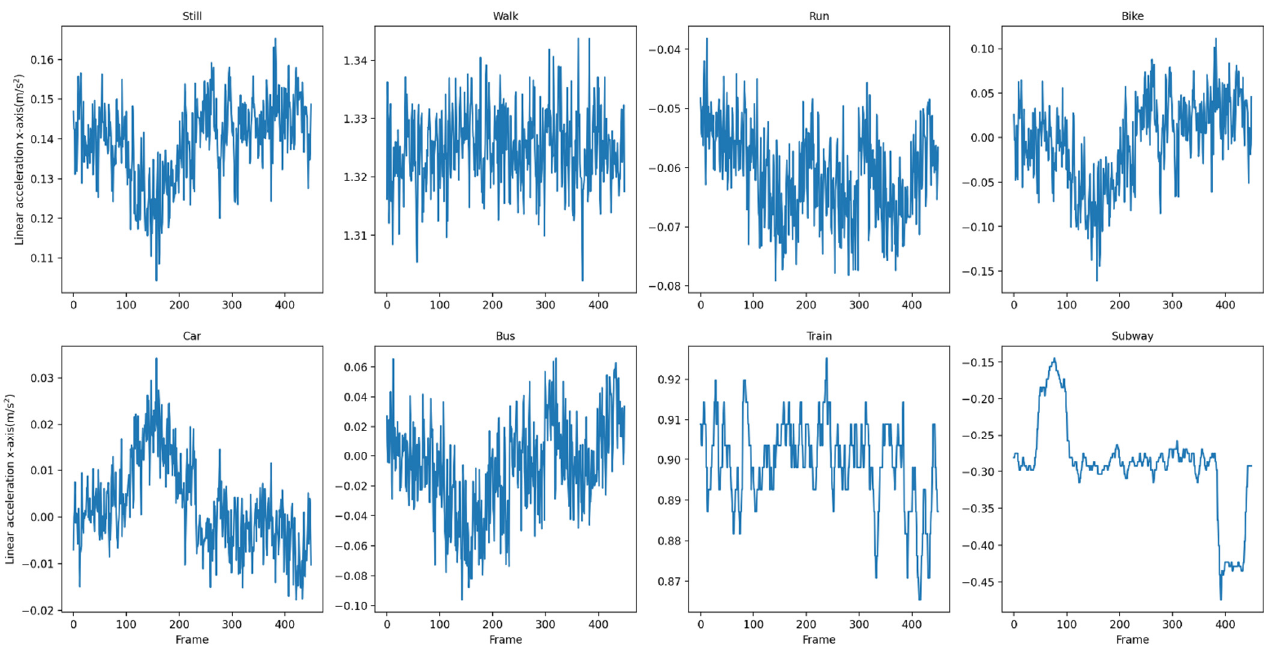
Figure 8. X -axis data for linear acceleration in the HTC dataset.